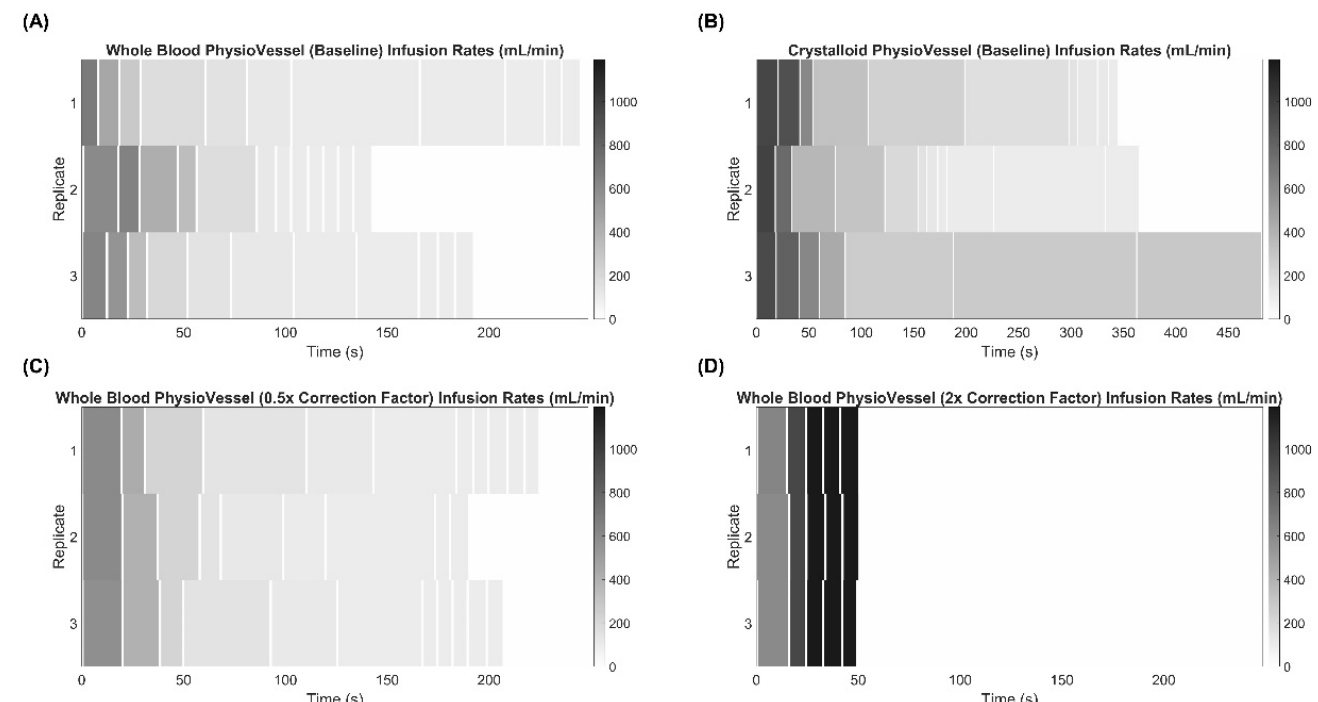
Figure 3. Effect of Adaptivity on the Adaptive Resuscitation Controller (ARC). Flow rate determined by ARC vs. time starting after initial hemorrhage to approximately 75 mmHg until the target of 95 mmHg was reached. Three technical replicates are shown as separate rows to illustrate how step sizes and flow rate changes varied. Heat map intensities range from 1200 to 0 mL/min for each, and time axes are equal for corresponding PV models to highlight the difference in rates to stabilize. Adaptive resuscitation controller results are shown first for the scaling factor set at 1 for ( A ) PV WB and ( B ) PV C . In addition, results are shown for the scaling factor ( C ) reduced to 0.5 or ( D ) increased to 2 using PV WB to highlight the adaptability of the system.